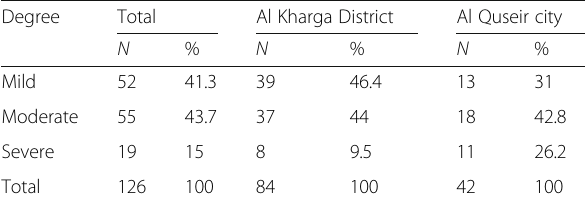
Table 3 Degree of Alzheimer ’ s dementia according to MMSE scores in Upper Egypt, Desert areas (AL Kharga and AL Quseir)